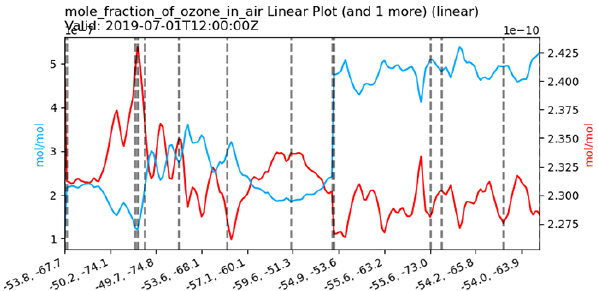
Figure 9. This shows an example of the linear view, with ozone volume mixing rations (blue) and CFC-11 (red) sampled along the flight